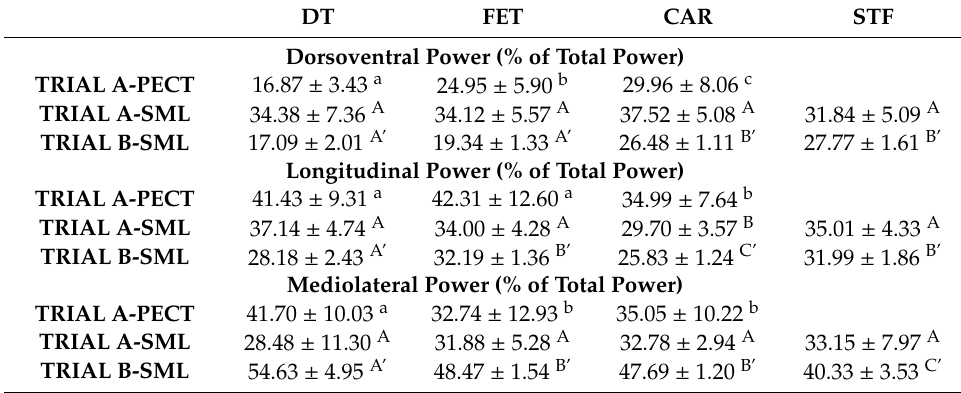
Table 1. Means and standard deviations of dorsoventral, longitudinal and mediolateral powers expressed as percentages of total power in horses exercised on a water treadmill at di ff erent water depths and velocities.